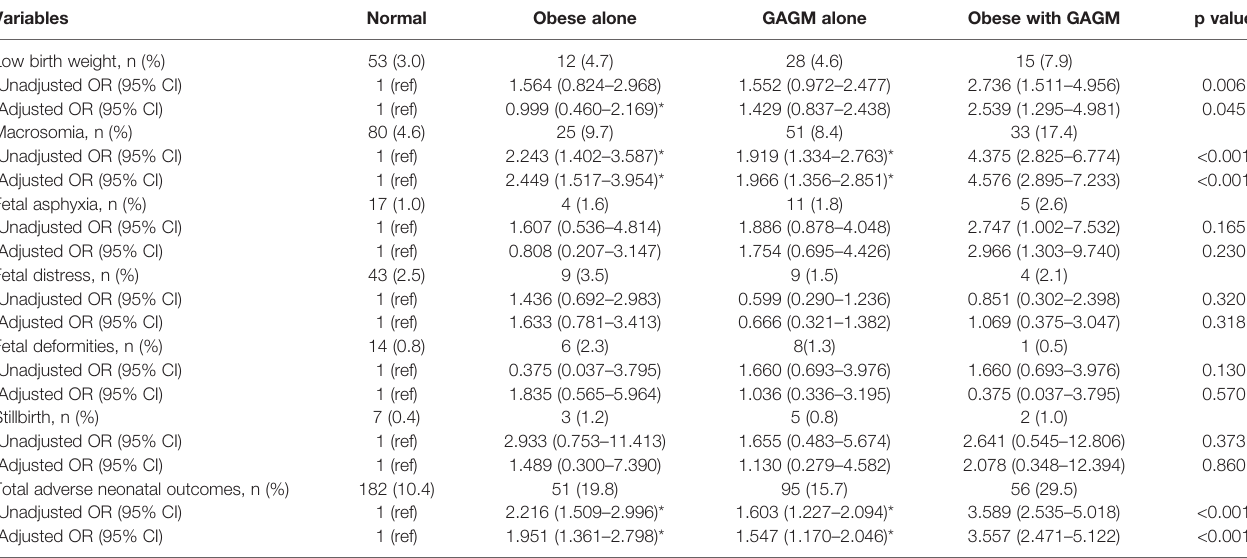
TABLE 3 | Association of maternal pre-pregnancy obesity and GAGM and adverse neonatal outcomes. Variables Normal Obese alone GAGM alone Obese with GAGM p value Low birth weight, n